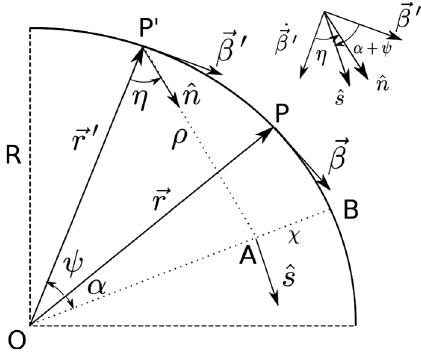
FIG. 1. Diagram of the 2D CSR model. P is the particle’s current position on the circular trajectory at time t , P 0 is its position at the retarded time t 0 where the fields at the observation point A is originated from. c is the angular separation between P and P 0 . The coordinate of A is denoted by its angular separation from P and its radial distance from the trajectory, i.e., A ð (cid:4); (cid:5) Þ . (cid:6) is the angle formed between P 0 A and P 0 O . The positive direction of the angles are also shown. ^ n and ^ s are unit vectors pointing from P 0 to A and perpendicular to OA ,